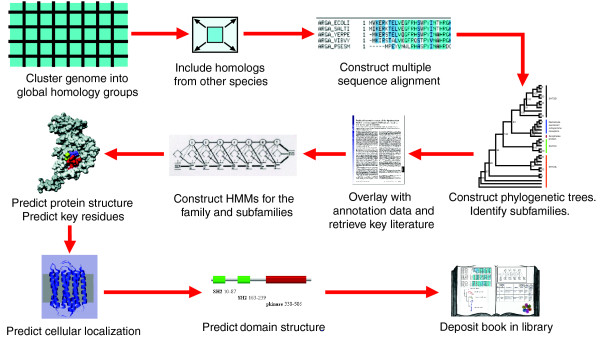
PhyloFacts whole-genome library construction pipeline. This figure represents our protocol for building global homology group protein family books. The pipeline starts with clustering a target genome into global homology groups (GHGs; sequences sharing the same overall domain structure), and proceeding through various stages of cluster expansion, multiple sequence alignment, phylogenetic tree construction, retrieval of experimental data, a variety of bioinformatics methods for predicting functional subfamilies, key residues, cellular localization, and so on, and quality control assessment.